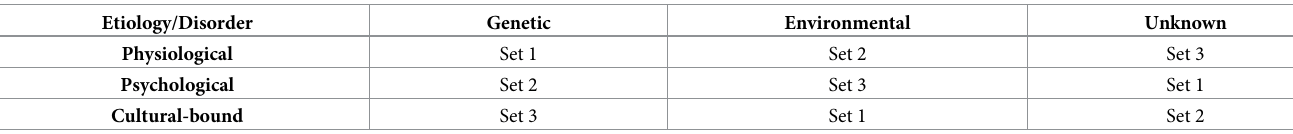
Table 2. Vignette sets randomization using an orthogonal Latin square